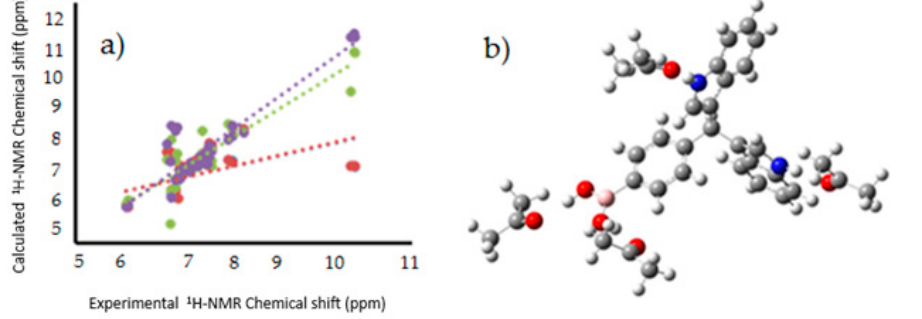
Figure 8. ( a ) Linear regression between experimental [12],and calculated 1 H-NMR chemical shifts for the target molecules in PCM (Red), explicit interaction (Green), PCM and explicit interaction (purple); ( b ) Model of explicit interaction for III with four acetone molecules. The gray, blue, pink, red and white spheres are for carbon, nitrogen, boron, oxygen and hydrogen atoms respectively.